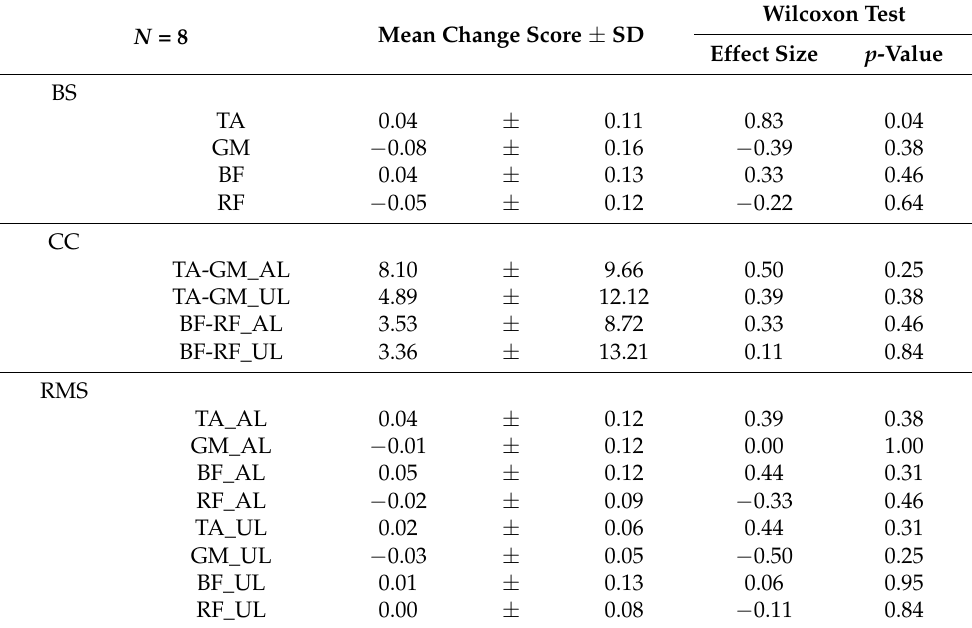
Table 4. Comparison of T1 and T2 change scores of each surface ElectroMyoGraphy (sEMG) outcome. N = 8